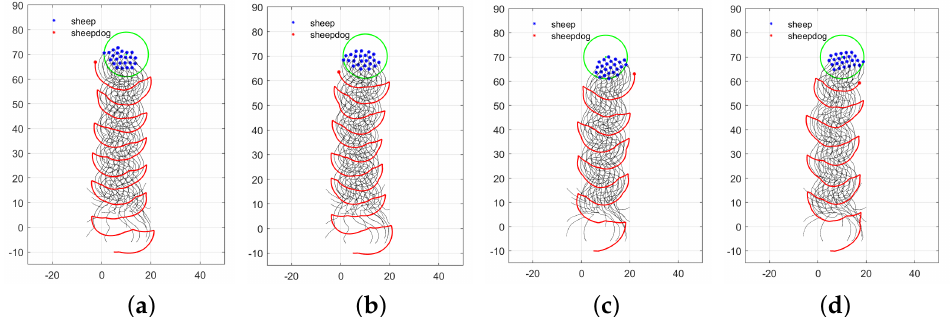
Figure 9. Motion trajectories of the sheep herd and sheepdog under Algorithms 1–4. ( a ) Algorithm 1. ( b ) Algorithm 2. ( c ) Algorithm 3. ( d ) Algorithm